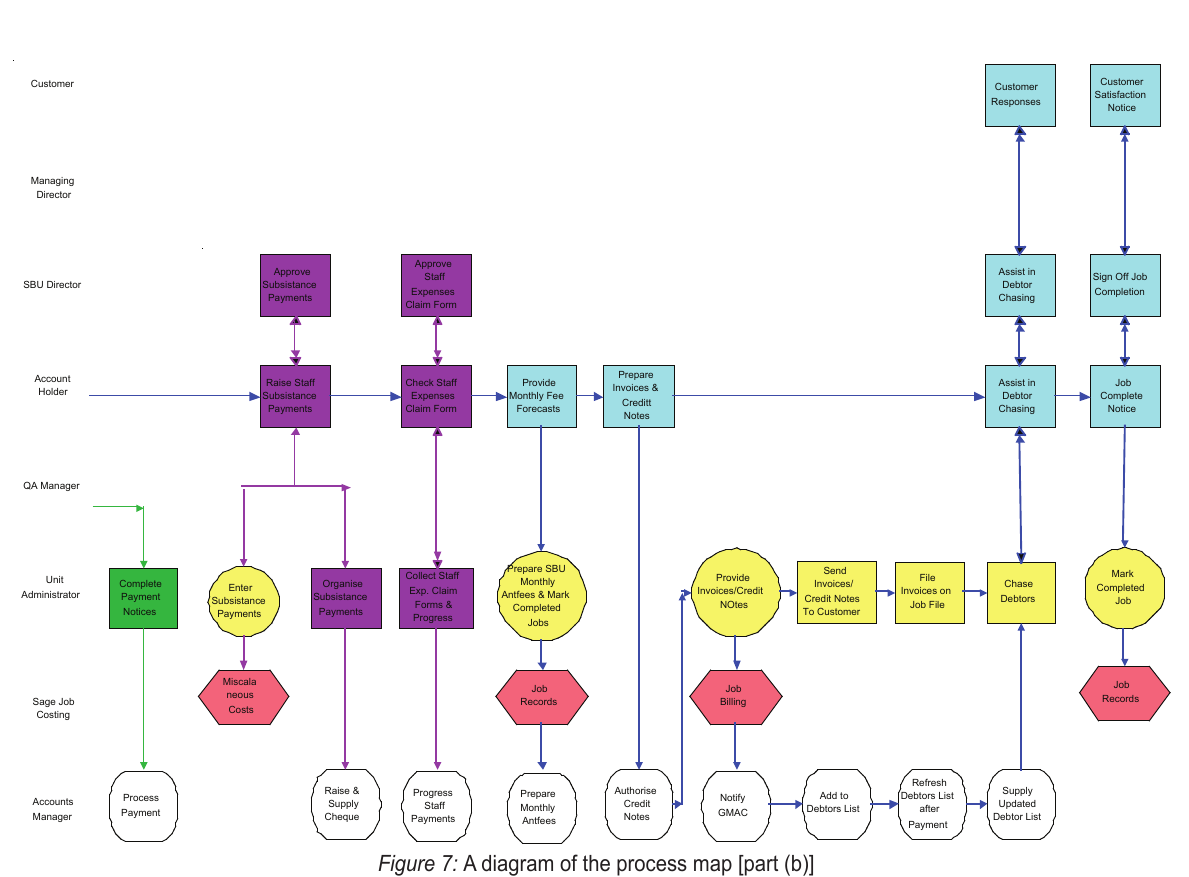
Figure 7: A diagram of the process map [part (a)]